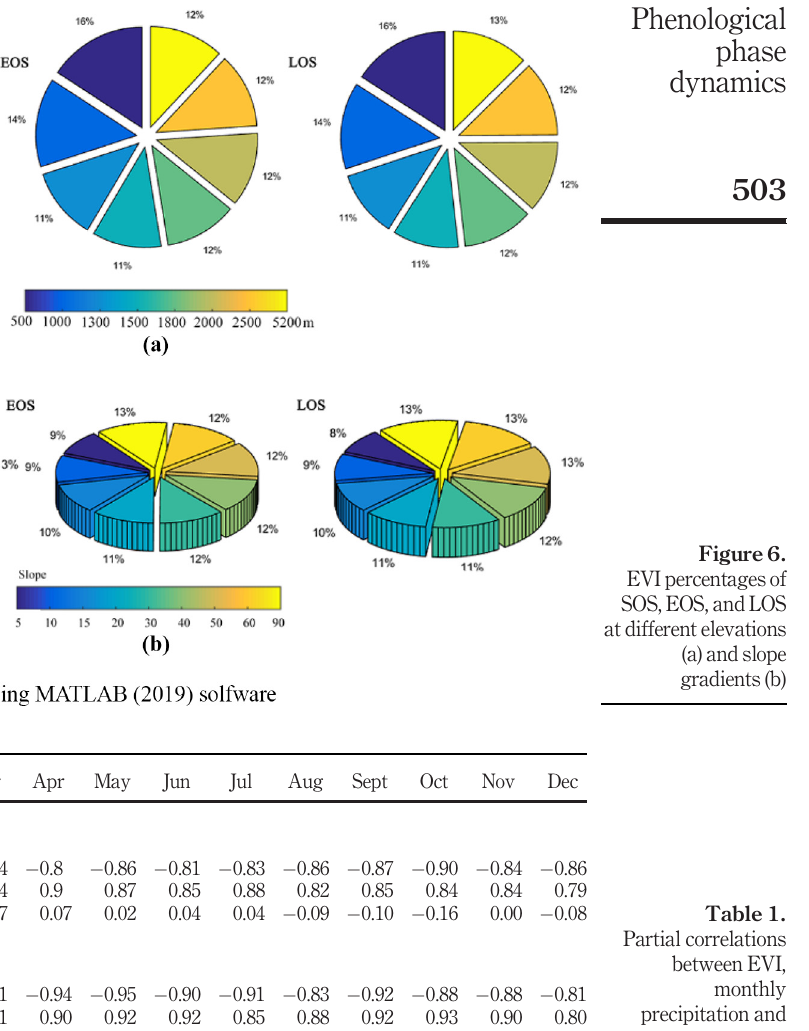
Table 1. Partial